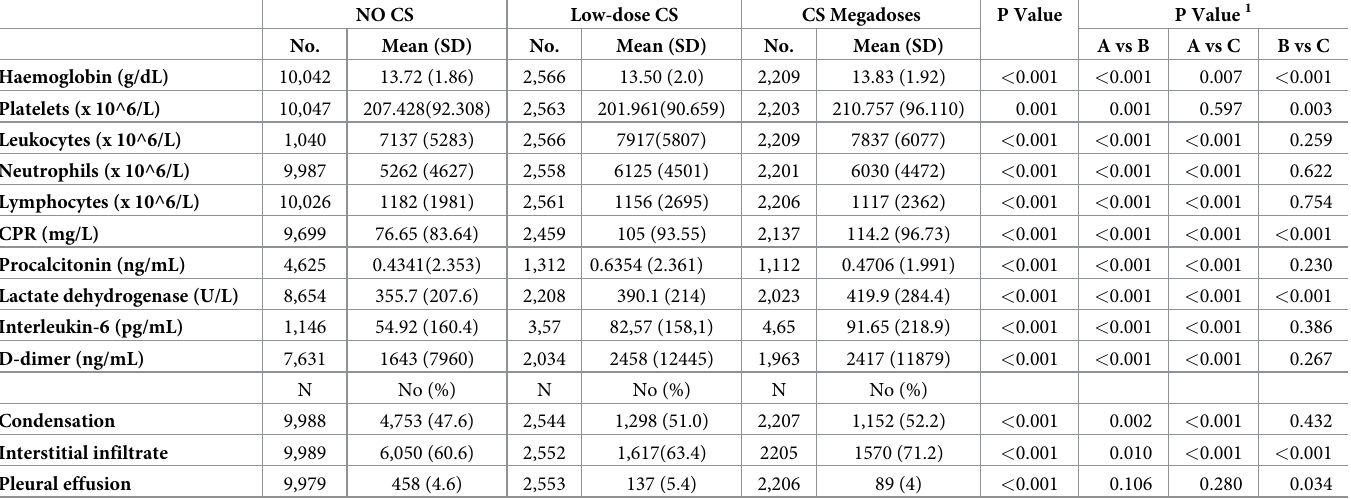
Table 2. Use of megadoses according to analytical parameters and radiological findings on admission.